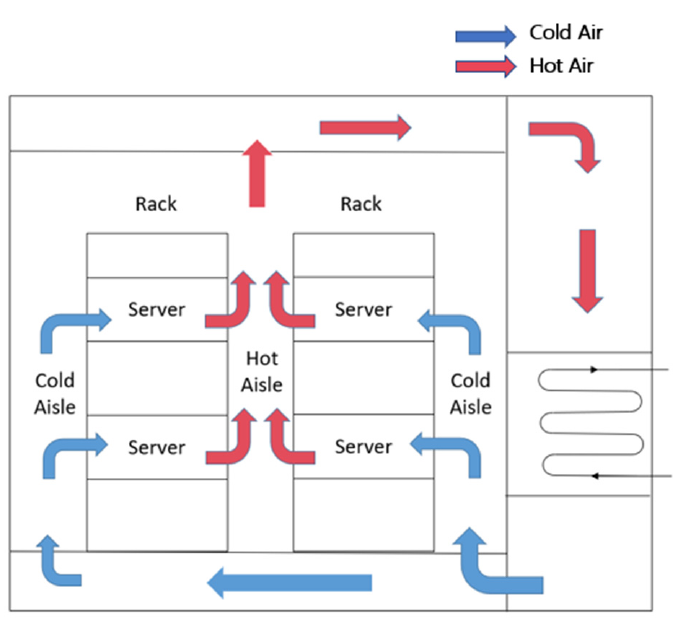
Figure 3. Direct air-side